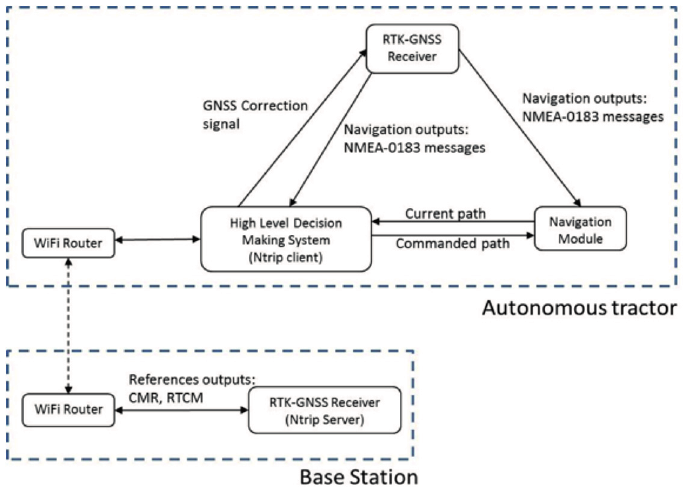
Figure 2. Flowchart of the autonomous tractor localization